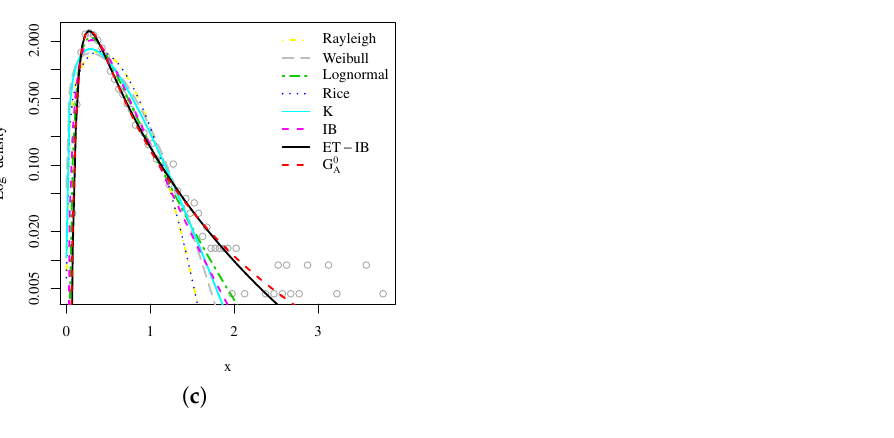
Figure 3. Log-frequency and estimated log-density of the ET-IB and competitor distributions for ( a ) forest region, ( b ) ocean region, and ( c ) urban region.